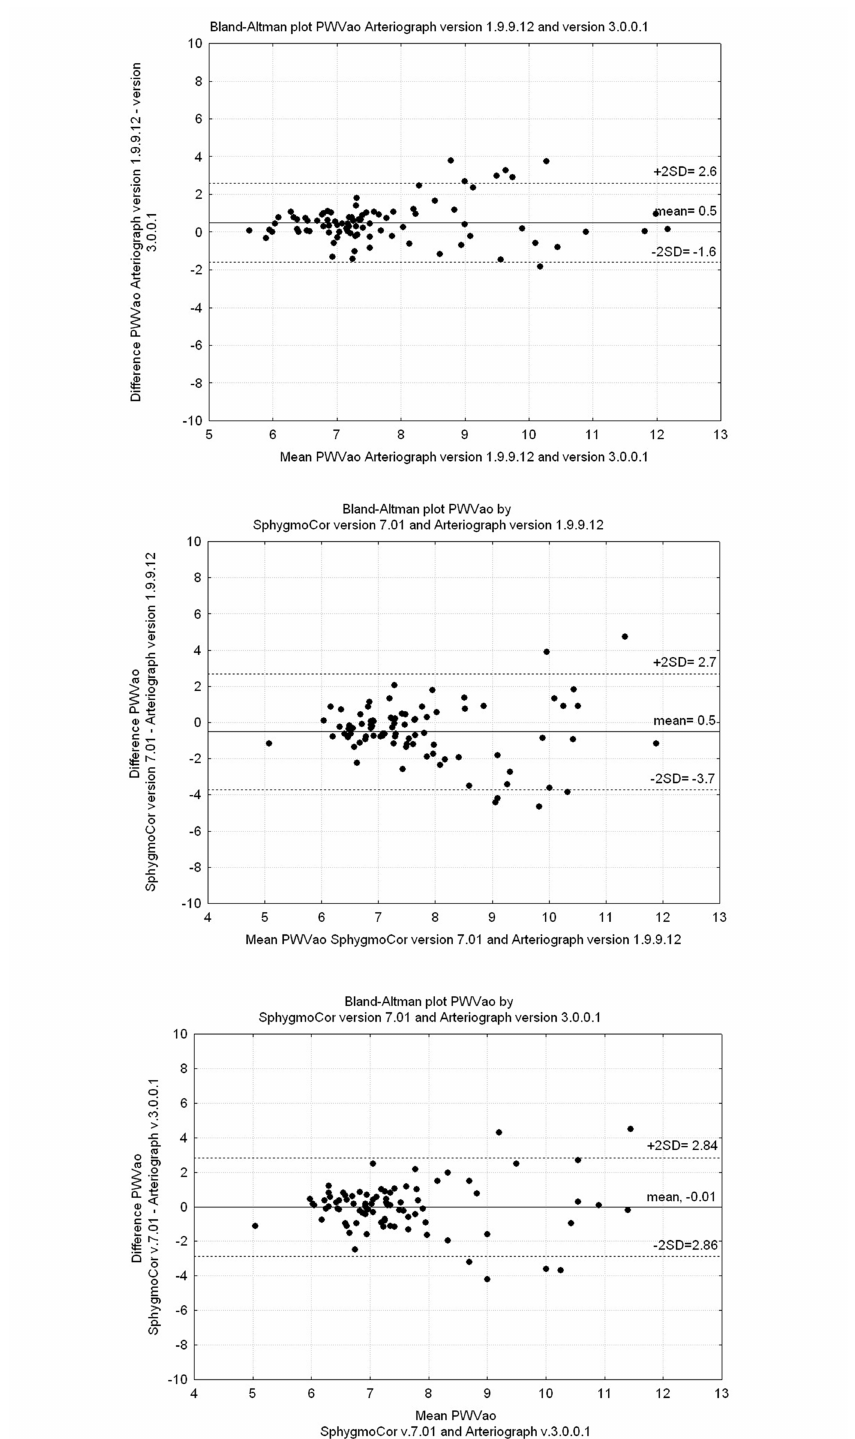
Fig 1. Bland-Altman plots showing PWVao. (Upper panel) Arteriograph v. 1.9.9.12 and v. 3.0.0.1. (Mid panel) SphygmoCor v. 7.01 and Arteriograph v. 1.9.9.12. (Lower panel) SphygmoCor v. 7.01 and Arteriograph v. 3.0.0.1.